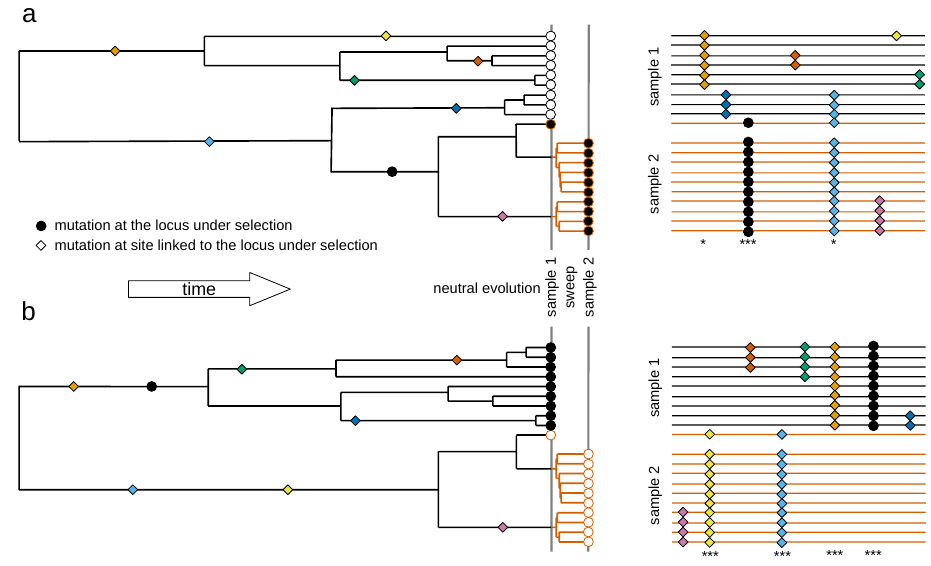
Figure 7 – Schematic representation of the consequences of selection on standing vari- ation in the temporal pattern of genetic diversity. Gene genealogies with samples car- rying the derived allele represented with a circle filled in black and samples carrying the ancestral allele represented with a circle filled in white. Mutations are represented as coloured squares over the genealogy at their time of mutation; the site under selection is represented with a circle filled in black. Lineages of the genealogy subject to positive selection are represented in red. Next to each genealogy a schematic representation of the sequence alignment of the samples is presented with each sequence represented as a line at the same height that the corresponding sample of the genealogy. Polymorphisms are represented with the corresponding coloured squares in the genealogy, indicating the sequences that carry the derived alleles. Sequences carrying the allele under posi- tive selection are represented with a red line. Asterisks signal polymorphic sites showing large (*) and extreme (***) changes in allele frequency between the two temporal sam- ples. This figure represents only a small region around the locus under selection that did not recombine through the period considered (hence can be represented as a single ge- nealogy). (a) Gene genealogy of two temporal samples taken just before a low frequency derived allele becomes advantageous and after the sweep. The mutation is young, as expected for a low frequency derived allele (Fig. 11), so the lineages carrying the allele that will become advantageous had little time to accumulate mutations and become dis- tinctive from other haplotypes in the population. Most of the alleles on the haplotypes that swept and are found in the second sample on high frequency were already at high frequency in the first sample. (b) Gene genealogy of two temporal samples taken just before a low frequency ancestral allele becomes advantageous and after the sweep. The mutation is old, as expected for a high frequency derived allele (Fig. 11); thus, the split between the lineages carrying the ancestral and derived allele is very old. Several muta- tions have accumulated in both lineages, making them very distinctive. Several alleles on the haplotypes that swept and are found in the second sample on high frequency were at low frequency in the first sample, creating a strong local signal of selection around the selected